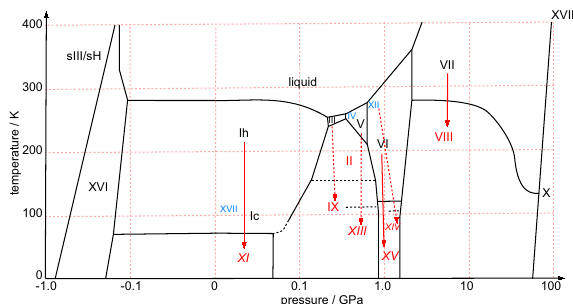
Fig. 1 Schematic phase diagram of crystalline ice phases inspired by Bartels-Rausch et al. 1 , Salzmann et al. 18 and Huang et al. 21 . Phases labeled with black Roman numerals are hydrogen-disordered phases; those labeled with red numerals are hydrogen-ordered phases; those labeled with blue numerals are metastable phases. The red solid arrows represent direct disorder-order transitions. The red dotted arrows represent disorder-order transitions that cross the stability range of another